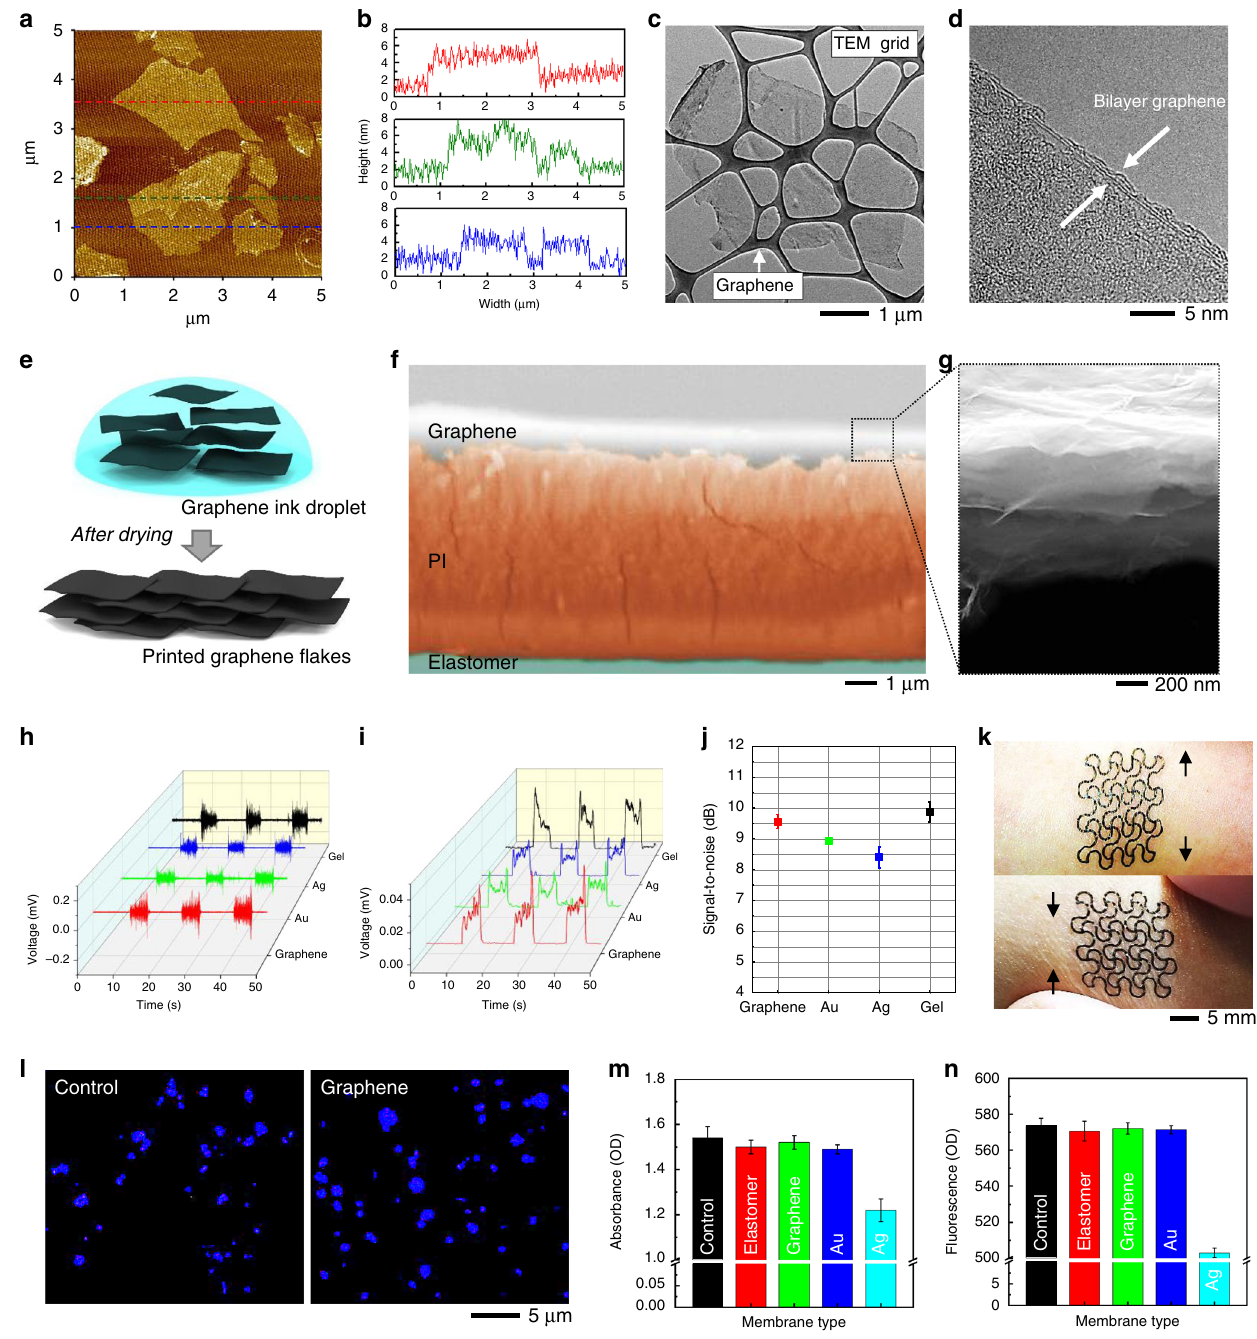
Fig. 2 Fabrication and characterization of a FCG and its application as a sensor. a AFM image (top view) of a FCG that was initially dispersed in aqueous ink on a mica substrate. b Three height pro fi les of FCG fl akes, corresponding to three dotted lines in a . c , d TEM images of a FCG with a low-resolution view ( c ) and high-resolution view ( d ). e Schematic illustration representing the stacking process of printed FCG before and after drying of an ink droplet. f Colorized, cross-sectional SEM image, showing a multilayered sensor structure, including graphene, PI, and elastomeric substrate. g Enlarged view of the SEM image in f , showing the stacked FCG layers with total thickness of 800nm. h Recorded EMG signals on forearm that compare the signal amplitudes with four electrodes, made of printed FCG (red), Au (green), Ag (blue), and commercial metal/gel (black). i Root-mean-squared data of EMG signals from ( h ). j Averaged signal-to-noise ratio of EMG data from a printed FCG (red), Au (green), Ag (blue), and commercial gel electrode (black): error bars show standard deviation ( n = 3). k Optical images showing a conformal lamination and stretchability of the FCG electrode on the skin: longitudinal stretching (top) and compression (bottom) on forearm. l Optical microscopic images of cultured keratinocyte cells after exposure to original DMEM (left; control sample) and DMEM with graphene (right) after 7 days of culture. m , n Comparison of cell absorbance ( m ) and fl uorescence intensity ( n ) of cultured keratinocyte cells on fi ve types of membranes, including control, elastomer, graphene, Au, and Ag. Overall, these data capture the cell friendly environments of a graphene electrode on an elastomeric